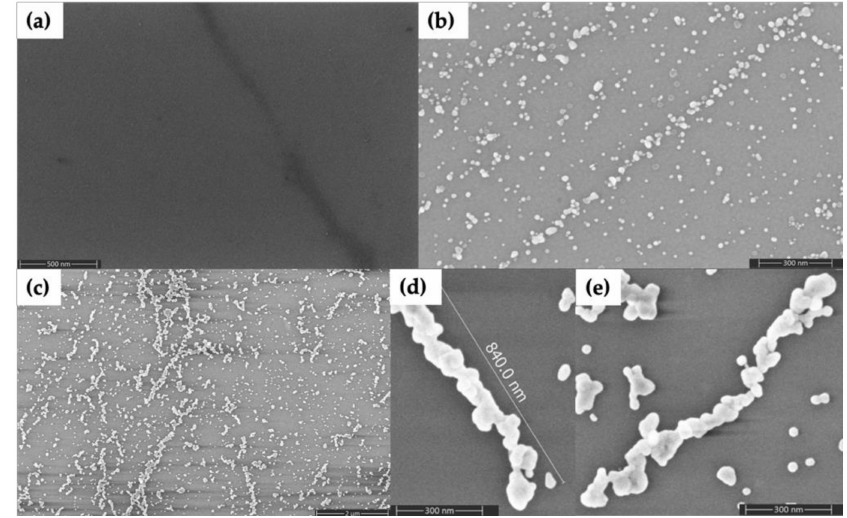
Figure 5. SEM images of DNA nanotubes seeded with Pd and subsequently plated with Au. ( a ) Pd seeded. ( b ) Pd seeded and step 1 Au plated. ( c ) Pd seeded and steps 1 and 2 Au plated. ( d,e ) Individual Pd seeded and steps 1 and 2 Au plated DNA